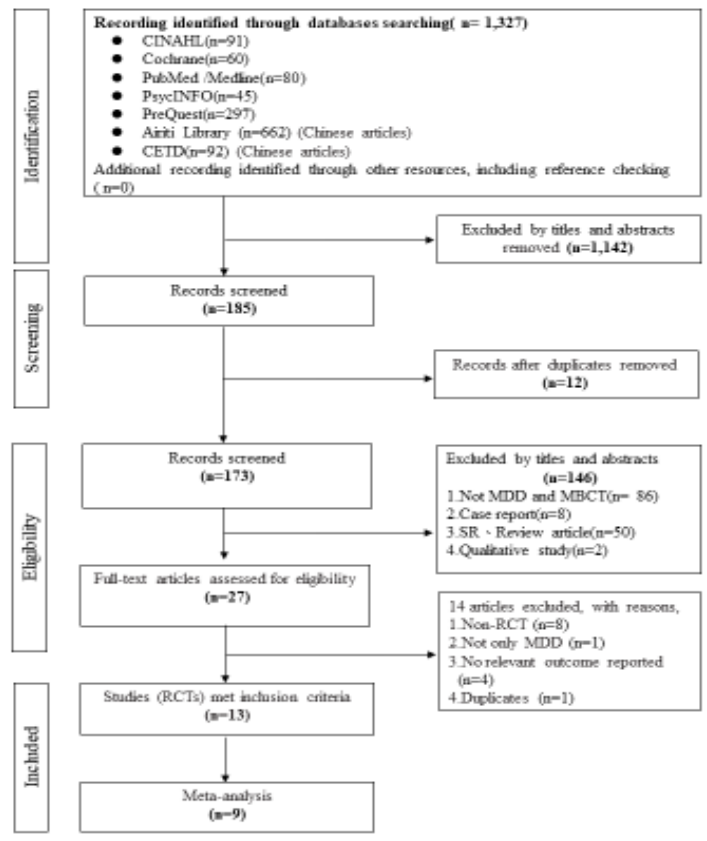
Figure 1. PRISMA diagram of study selection.